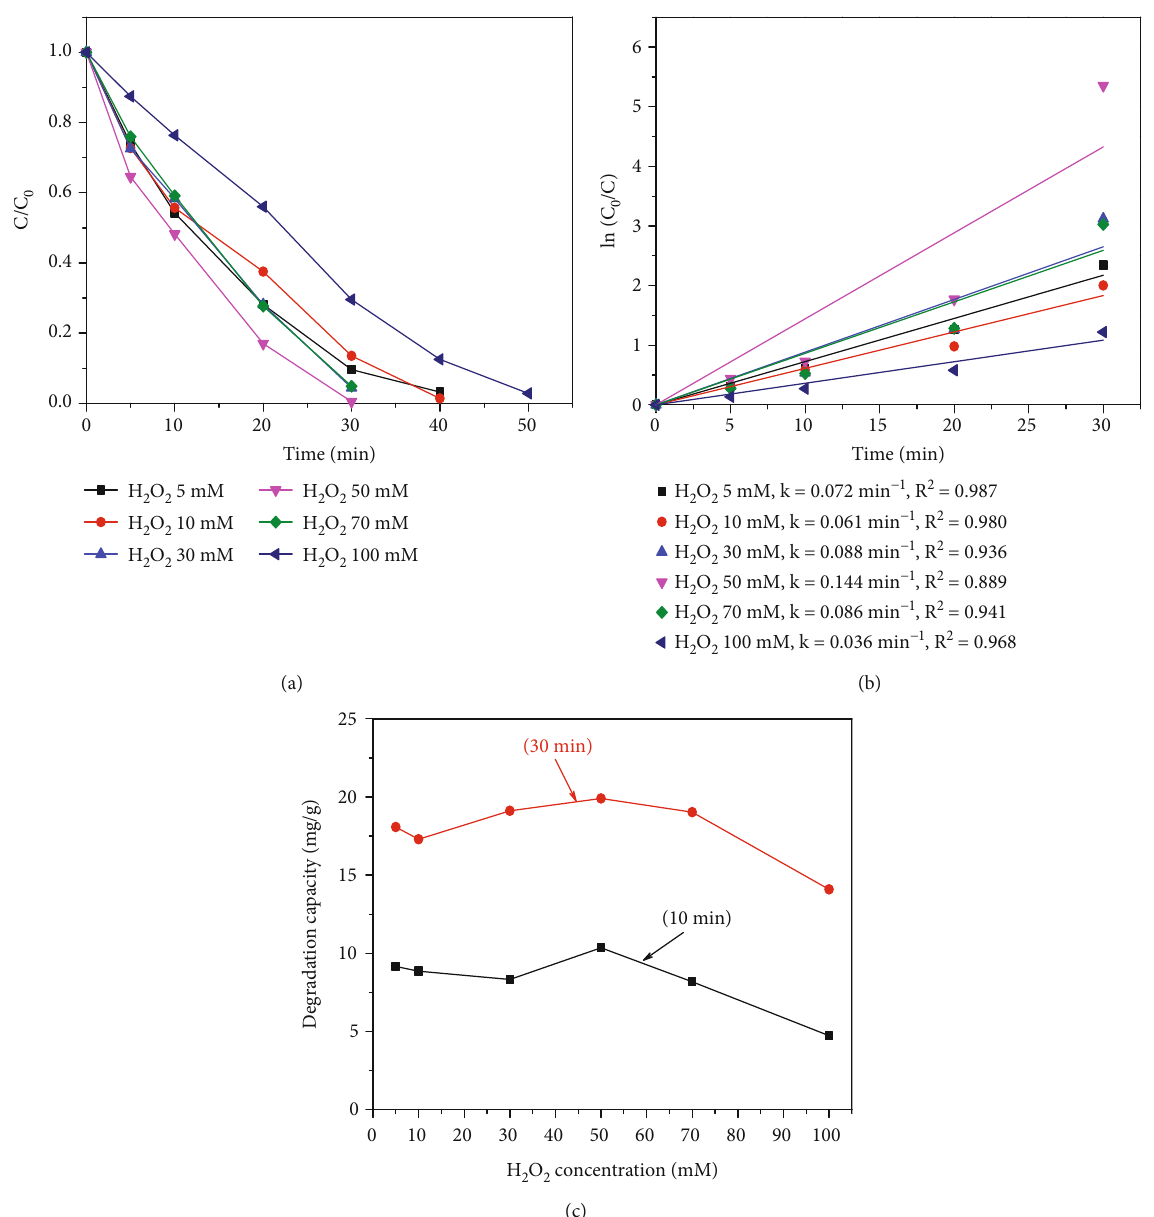
O concentration on degradation of tartrazine, (b) the kinetic curves, and (c) the DC with di ff erent H 2 2